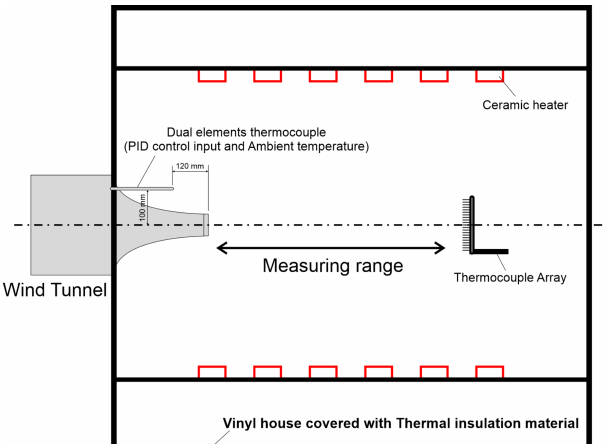
Figure 4. Temperature-controlled enclosure chamber schematic.